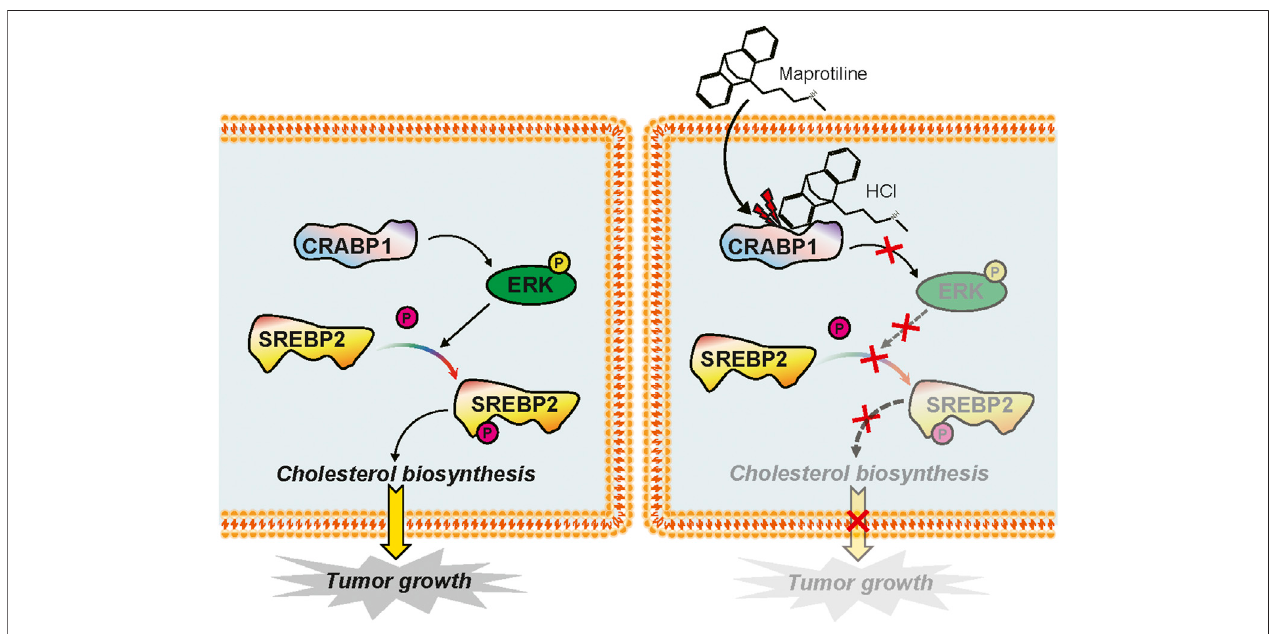
FIGURE 7 | Mechanism diagram of maprotiline in HCC